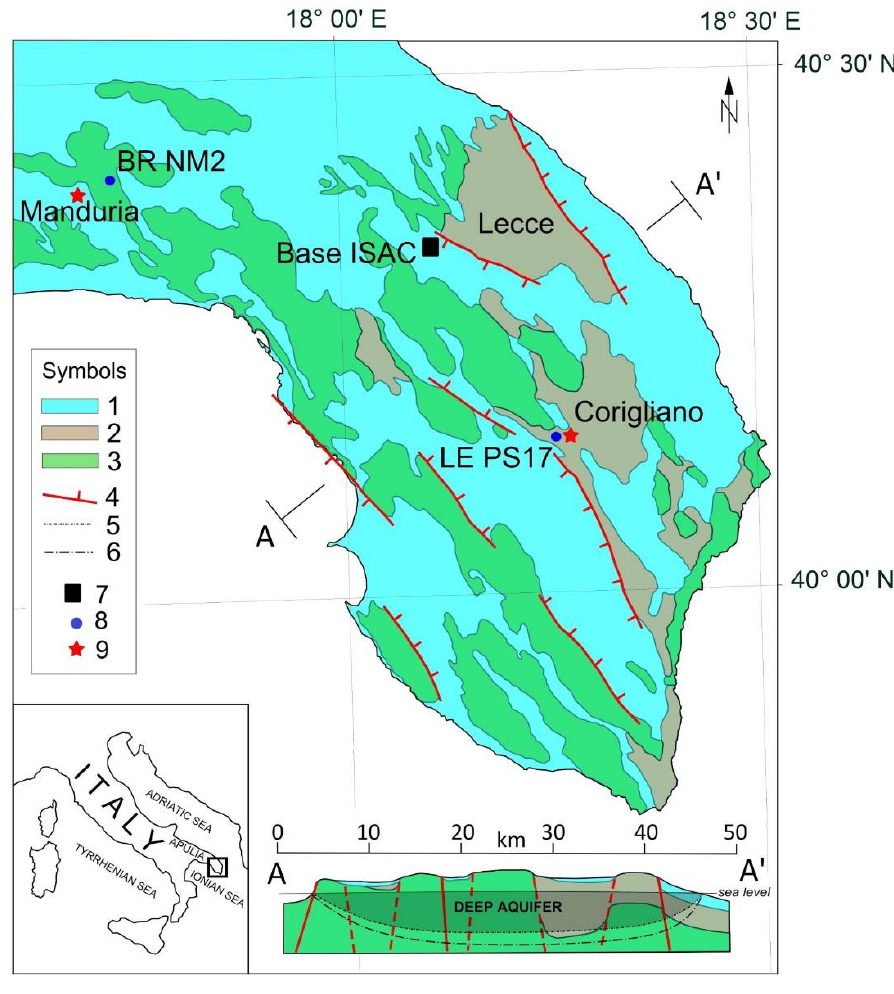
Figure 2. Geological map of Salento Peninsula and locations of the CNR-ISAC base, wells LE-PS17 and BR-NM2 and Manduria and Corigliano rain gauges; legend: (1) coarse calcarenites and clayey-marls (Quaternary), (2) fine calcarenites (Tertiary), (3) limestone (Cretaceous), (4) main faults, (5) fresh water/brackish water interface, (6) brackish water/saltwater interface, (7) micrometeorological base, (8) Tiziano project well, (9) rain gauge; vertical scale magnified ten times in A-A’ section.